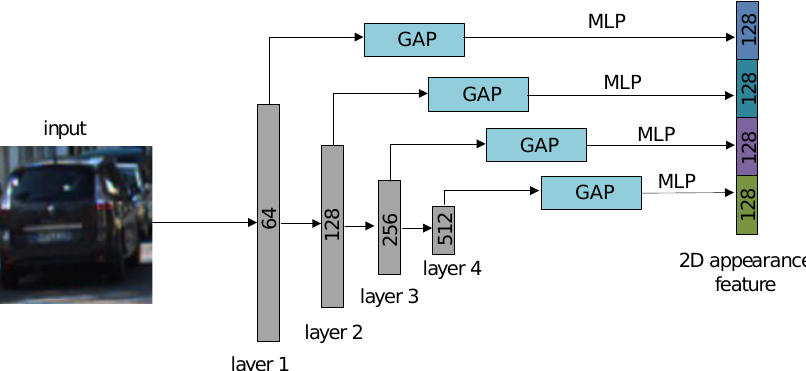
Figure 2. Modified VGG-16. The module takes the cropped and resized object patches with dimension 224 × 224 as input, and the layers output 64, 128, 256, 512 channels of the features, respectively, after a max pooling operation. Next, the global average pooling (GAP) operation and multi-layer perceptron (MLP) are used to obtain semantic features with 128 channels for each layer. Finally, all the layers are concatenated together to generate the global feature that contains the information in all the